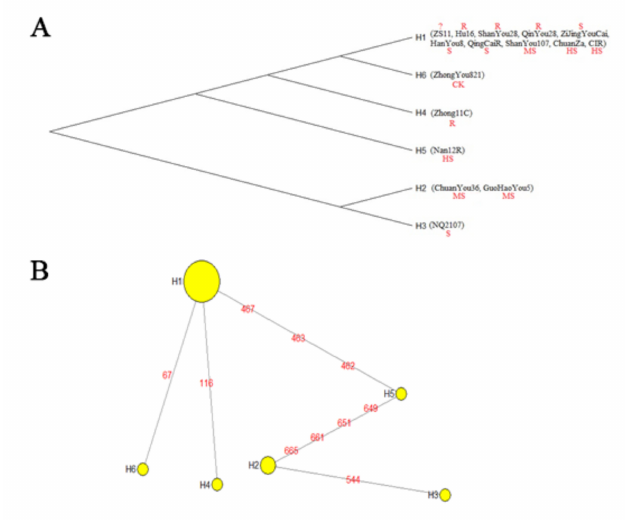
Figure 4. BnP5CR2 gene-CDS-haplotype diversity. ( A ) Haplotype network. ( B ) Haplotype phylogeny. Note: ( A ) Red color is resistance rating corresponding to each cultivar. “?” means that the disease resistance of Z11 is unknown. ( B ) The size of the yellow nodes is proportional to frequencies. The red value displays mutated positions.